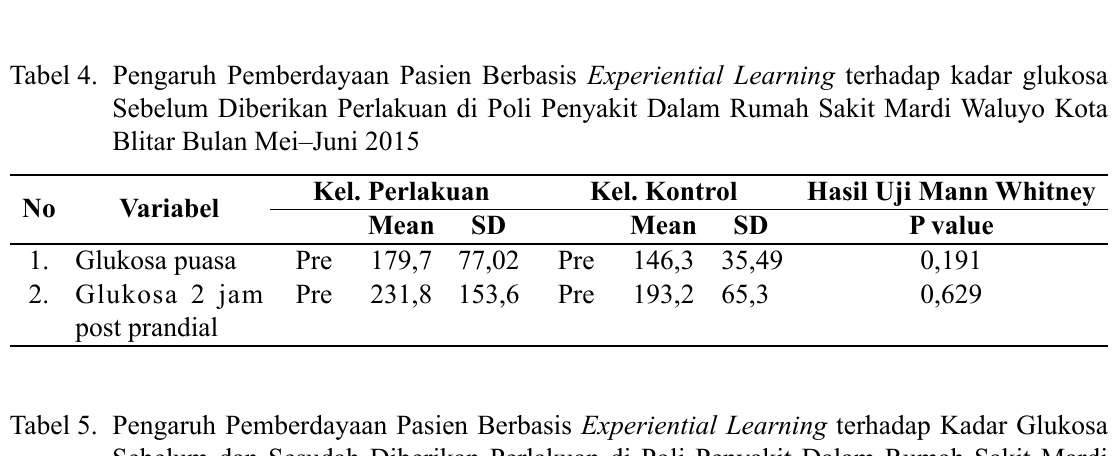
Tabel 5. Pengaruh Pemberdayaan Pasien Berbasis Experiential Learning terhadap Kadar